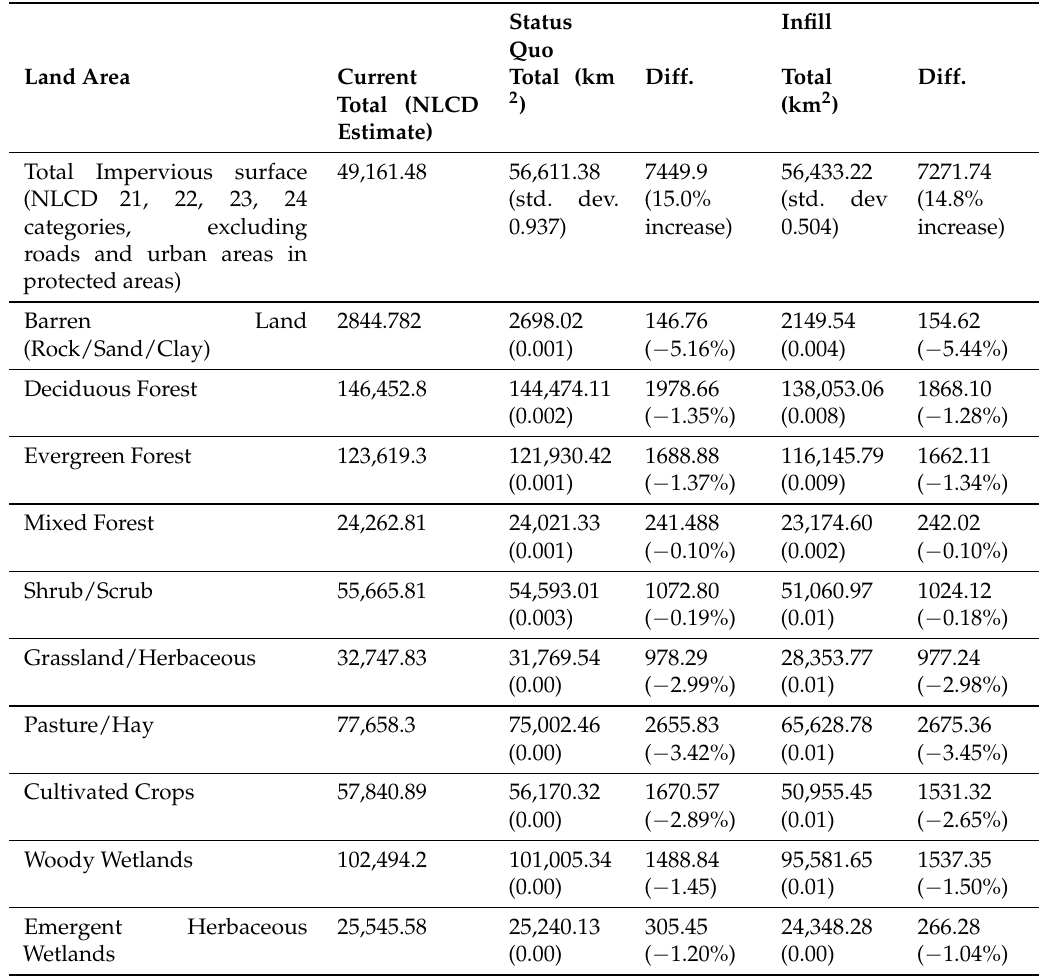
Table A1. Land use/cover change (average simulated 2050/total 2011) under the Status Quo and Infill urban growth scenarios.